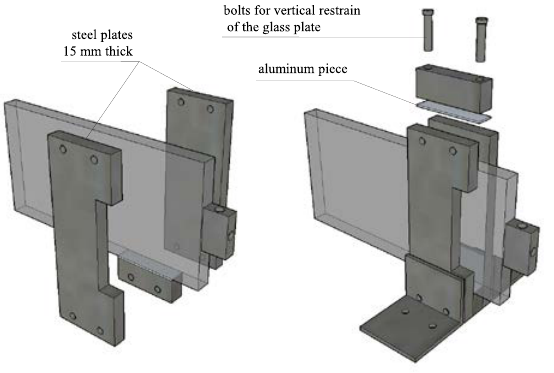
Fig. 6 Set-up for shear testing of the TSSA edge bonded